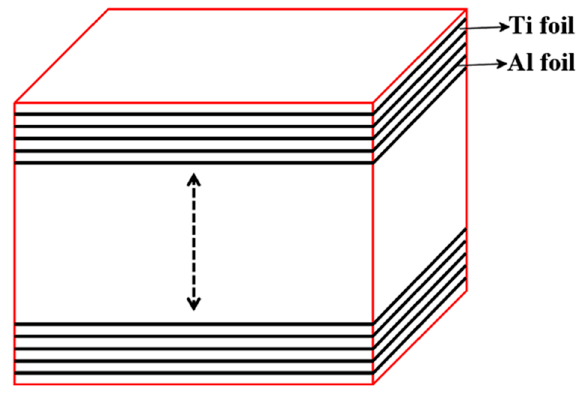
Figure 1. Schematic sequence of stacking of the elemental components.